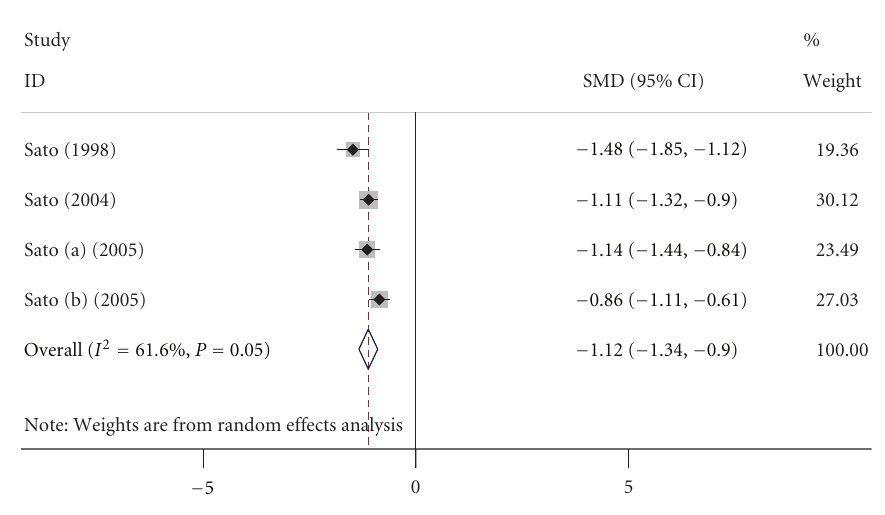
Figure 4: Pooled estimate of SMD and 95% CI of AD and hip BMD (mmAl). SMD is represented by squares, whose sizes are proportional to the sample size of the relative study. The whiskers represent the 95% CI. The diamond represents the pooled estimate based on the random e ff ects model, with the centre representing the point estimate and the width the associated 95%